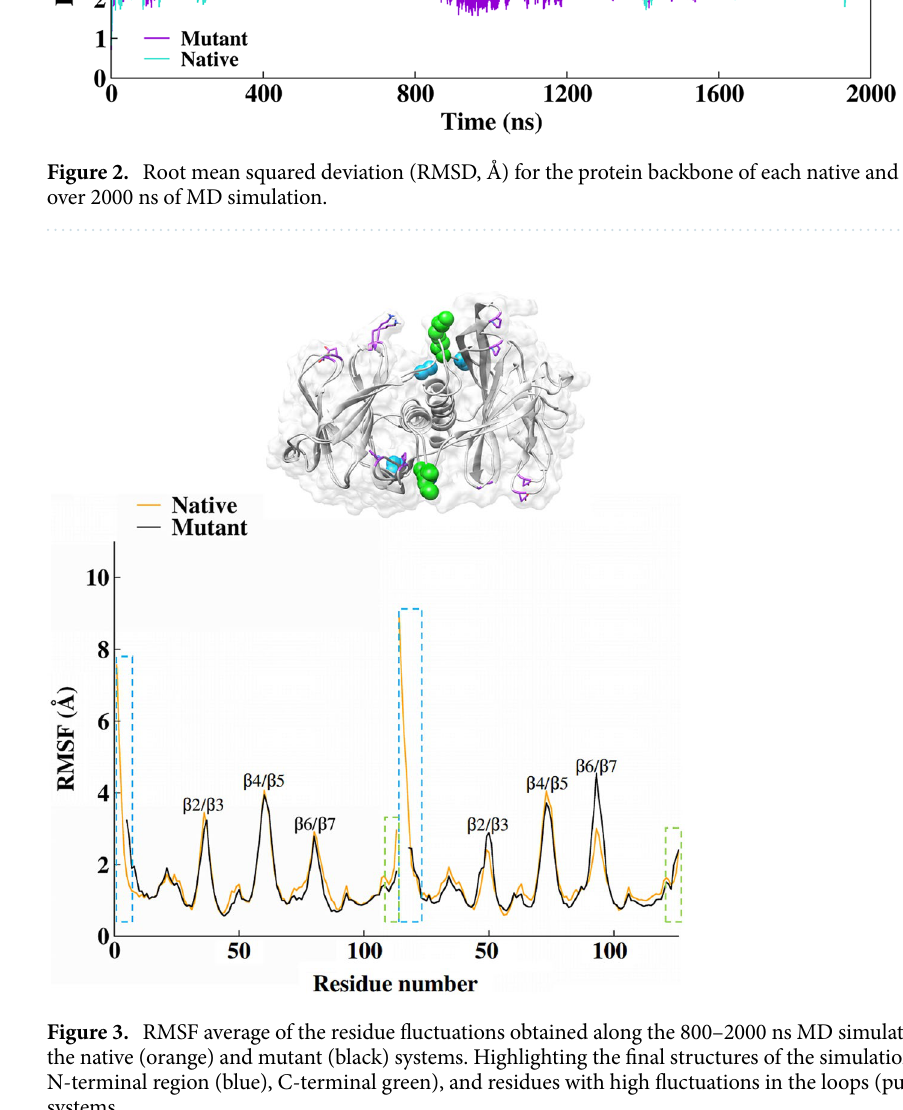
structure. Comparing the mutant structure against the native as the reference structure, the lDDT score (a local superposition-free score for comparing protein structures) is plotted as a function of the residue numbers. Devia- tion of no more than 0.9 was observed (Fig. S4). Additionally, the flexibility of each system was verified by means of the fluctuations of the backbone atoms for each residue. In consequence, the Root-Mean-Square Fluctuations (RMSF) were calculated to characterize the local movement of residues in the dimeric systems (see Fig. 3). Overall, the RMSF data show similar trends obtained for both native and mutant systems. Figure 3 indicates that the residues with higher fluctuation values are located in the N and C-terminals regions (blue and green marks in Fig. 3, respectively), they present high flexibility that amounts to 10 Å. Furthermore, the other regions with relevant fluctuations correspond to regions of the β2/β3, β4/β5, and β6/β7 loops that connect the β-sheets inside the barrel (residues highlighted in purple). The N-terminal regions in monomers A show similar fluctua- tions, whereas the monomer B in the mutant system has a smaller fluctuation. To better understand the conformational changes of the binding regions at the dimer interface, it is necessary to analyze the movements in more detail. Therefore, the final trajectories of the native system were analyzed through cluster analysis by grouping the poses extracted from the MD simulations. In general, the three most